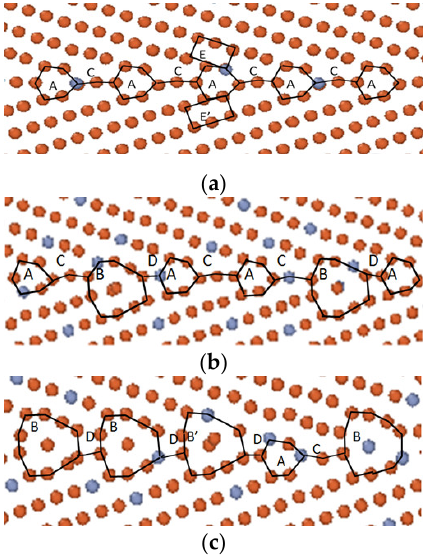
Figure 6. Structures of the Σ9(221) GBs in the Fe-X at.% Cr alloys (X = 1, 3, and 9). ( a ) X = 1, ( b ) X = 3, and ( c ) X = 9. Red circles represent Fe atoms and light gray circles represent Cr atoms.